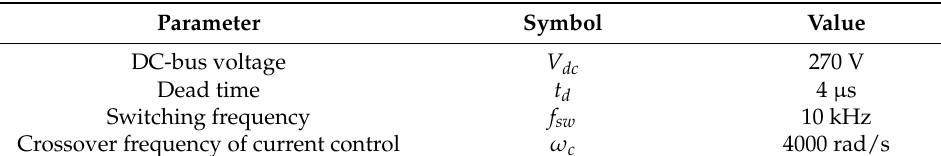
The DC i m was controlled with the DC power supply ZX-800L, Takasago Ltd. and the armature currents were supplied by the three-phase inverter MWINV-5R022, Myway Plus Corporation. The electrical conditions and the control block diagram are shown in Table 6 and Figure 22, respectively. As shown in Table 6, the dead time was 4 μs and the error Table 6. Experimental conditions of current control of prototype motor. voltage of the dead time was compensated based on the reference [18,19]. In addition, as Table 6. Experimental conditions of current control of prototype motor. shown in Figure 22, the relationship between the Ψ a and i m expressed in Equation (1) was used for the decoupling item. Parameter Symbol Value DC-bus voltage V dc 270 V Table 6. Experimental conditions of current control of prototype motor. Dead time t d 4 µ s